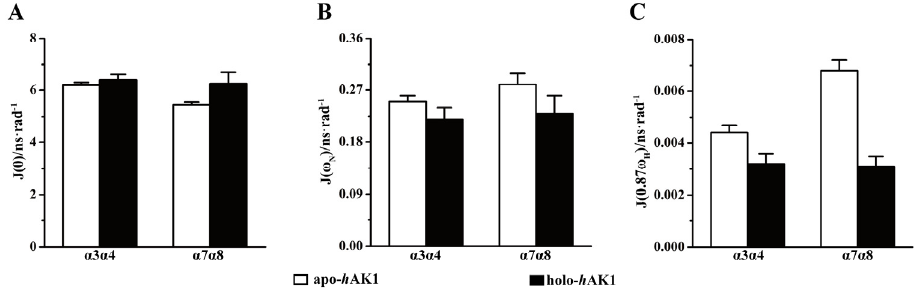
α 3 α 4 in the NMP domain and α 7 α 8 in the LID domain are highlighted in blue and red, respectively.